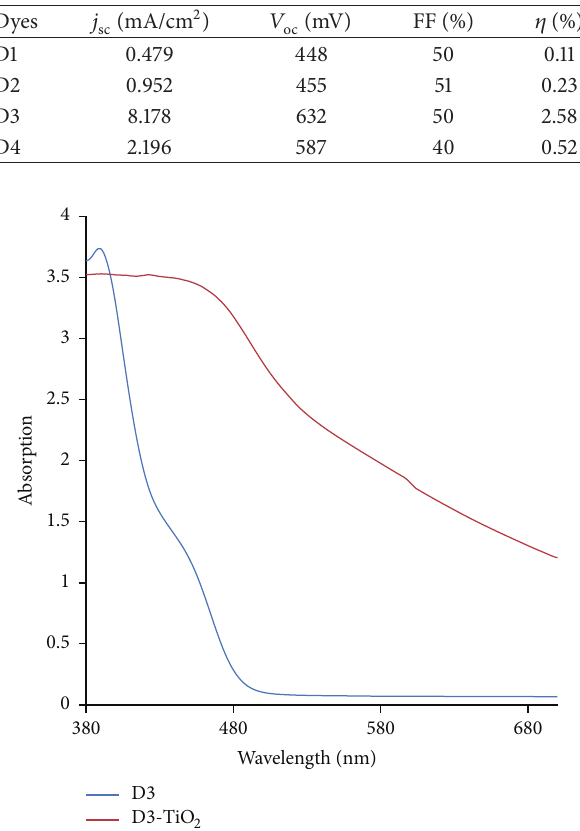
Table 2: PV properties of DSSCs.